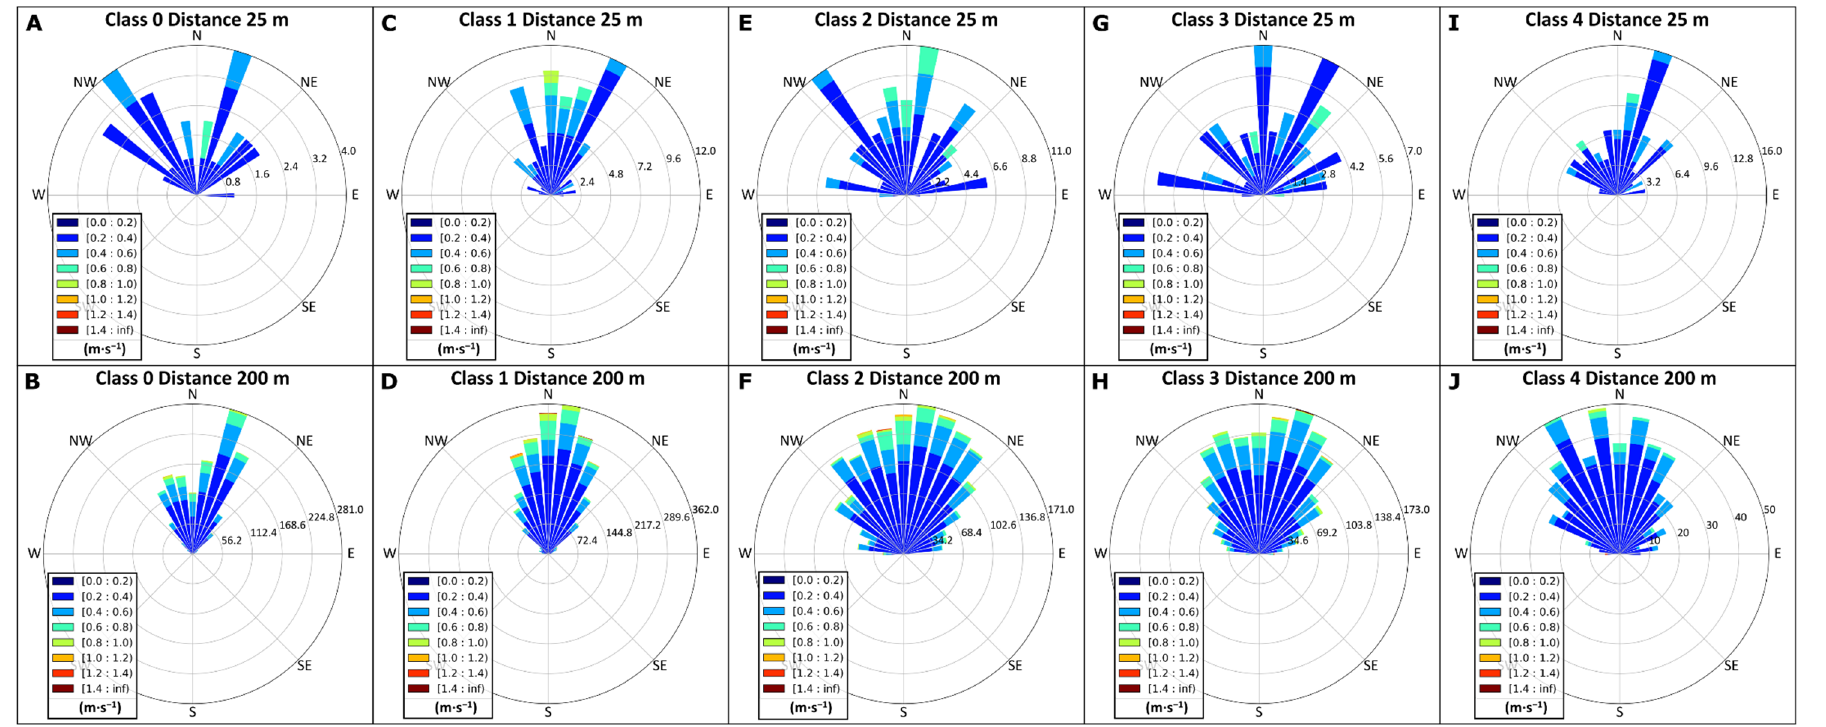
Figure 8. Polar plots indicating current speed and orientation for ( A ) class 0 ≤ 25 m proximity to the “mounds”, ( B ) class 1 ≤ 200 m proximity to the “mounds”, ( C ) class 1 ≤ 25 m proximity to the “mounds”, ( D ) class 1 ≤ 200 m proximity to the “mounds”, ( E ) class 2 ≤ 25 m proximity to the “mounds”, ( F ) class 2 ≤ 200 m proximity to the “mounds”, ( G ) class 3 ≤ 25 m proximity to the “mounds”, ( H ) class 3 ≤ 200 m proximity to the “mounds”, ( I ) class 4 ≤ 25 m proximity to the “mounds”, ( J ) class 4 ≤ 200 m proximity to the “mounds”.